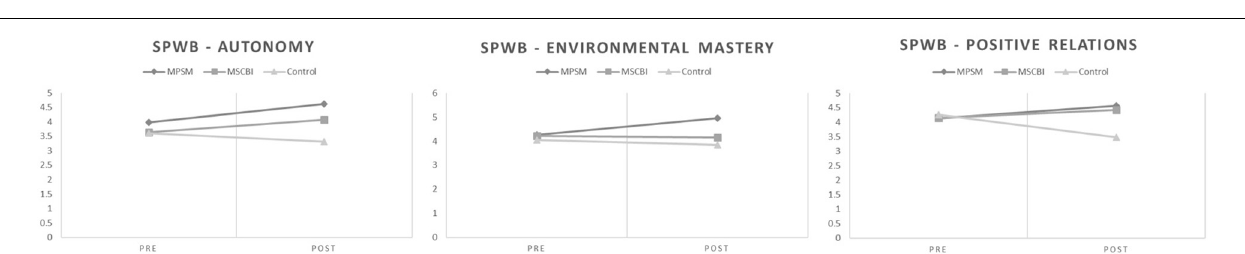
FIGURE 2 | Means estimated for the MBSR group, MPSM group, and control group on pre-intervention and post-intervention time points, for spwb dimensions with statistically significant interaction